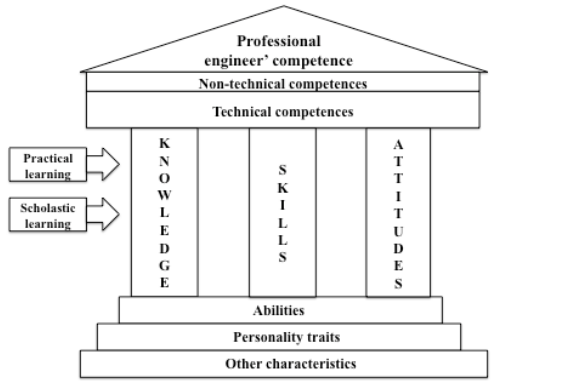
Figure 2. Architectural Model of Engineers’ Competences (modified by D. Bartram and R.A. Roe,